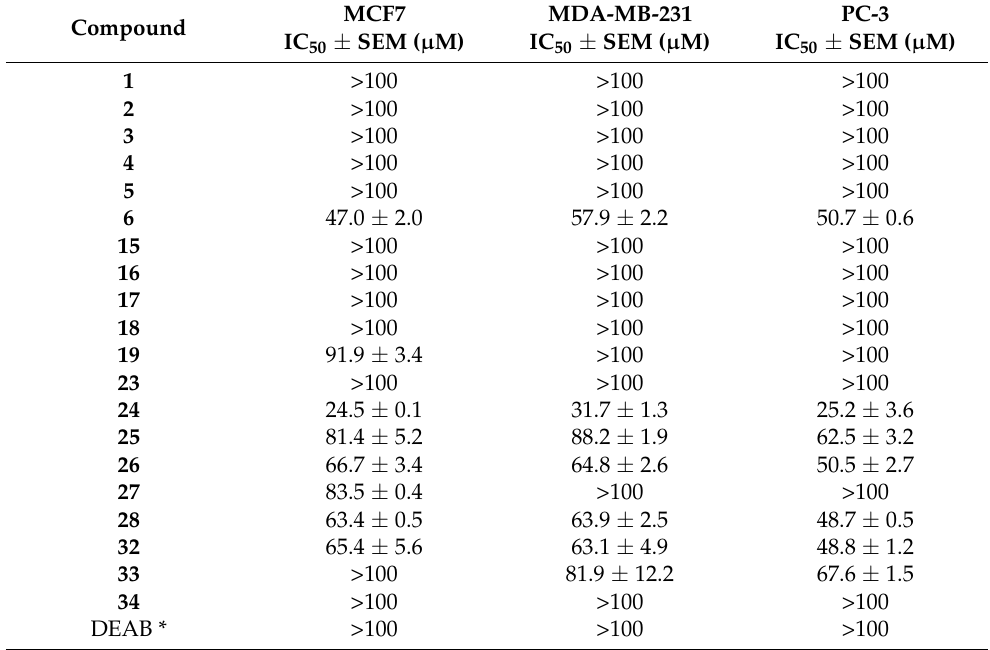
Table 1. Cytotoxicity (IC 50 ± SEM) of 1 – 6 , 15 – 19 , 23 – 28 , 32 – 34 , and DEAB on MCF7, MDA-MB-231, and PC-3 cell lines after treatment for 48 h; n = 3.